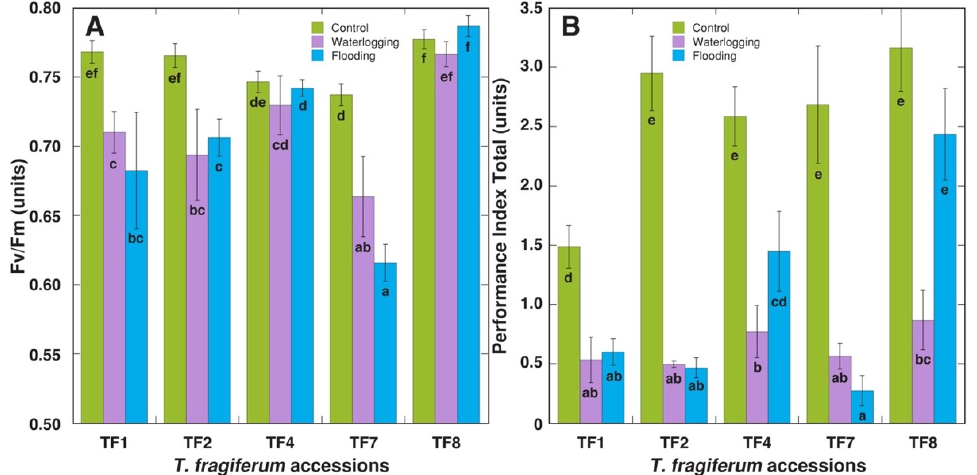
Figure 2. Direct effect of increased soil moisture in the form of waterlogging and flooding on chlorophyll a fluorescence parameters Fv/Fm ( A ) and performance index total ( B ) of Trifolium fragiferum plants of different accessions. Measurements were performed after three weeks of treatment. Data are means ± SE from five plants, with three independent measurements each. Different letters indicate statistically significant differences ( p < 0.05).